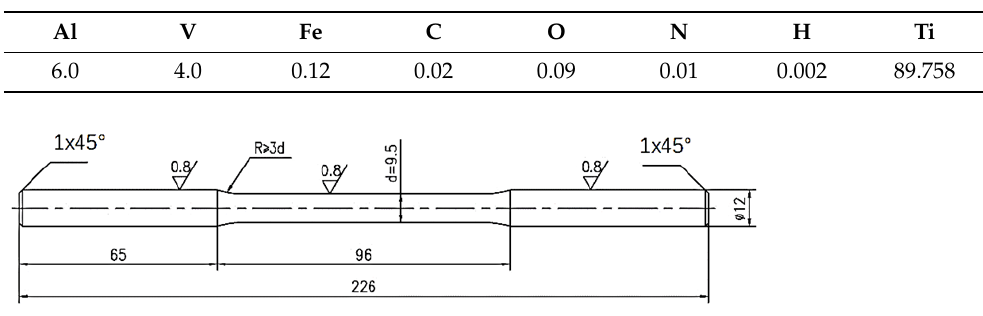
Figure 1. Size diagram of fatigue sample.